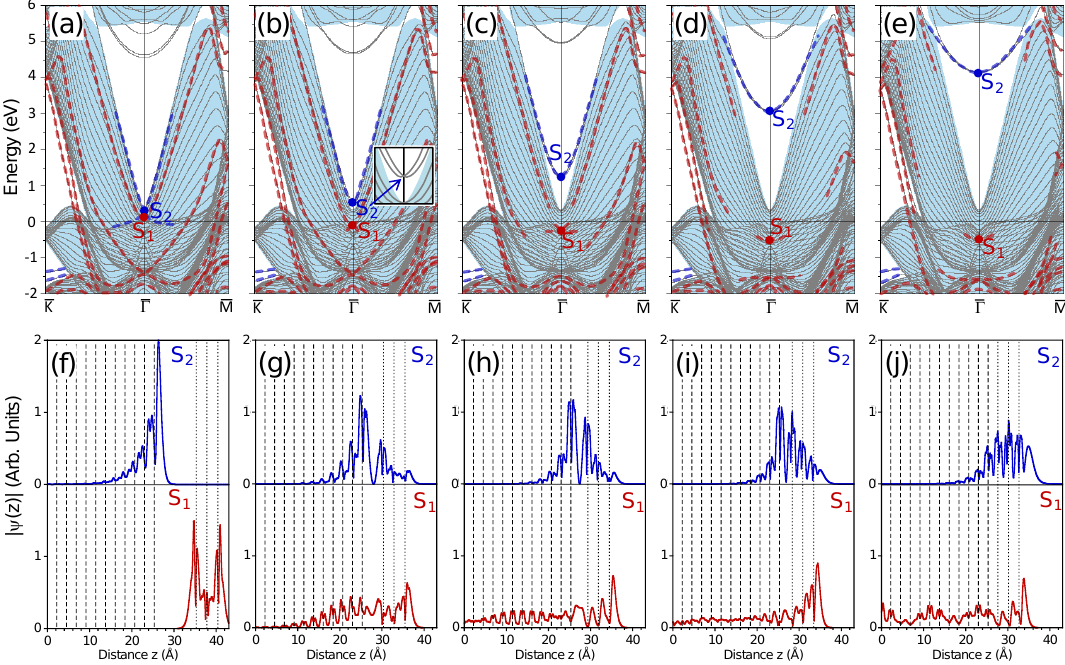
Figure 3. Electronic structure of the 3 ML Au/Pt(111) surface at ( a ) 10 Å, ( b ) 5 Å, ( c ) 4 Å, ( d ) 3 Å, and ( e ) the equilibrium distance between the top Pt and closest Au atomic layers. The surface states discussed in the text are marked as S 1 and S 2 . In ( b ), insert zooms into the region in the vicinity of the S 2 state. Panels ( f – j ) present respectively the in-plane averaged charge density distributions of the S 1 (red) and S 2 (blue) surface states. In ( f – j ), vertical dashed (dotted) lines show the positions of the Pt (Au) atomic layers. The central atomic layer of the 23 ML Pt slab is placed at